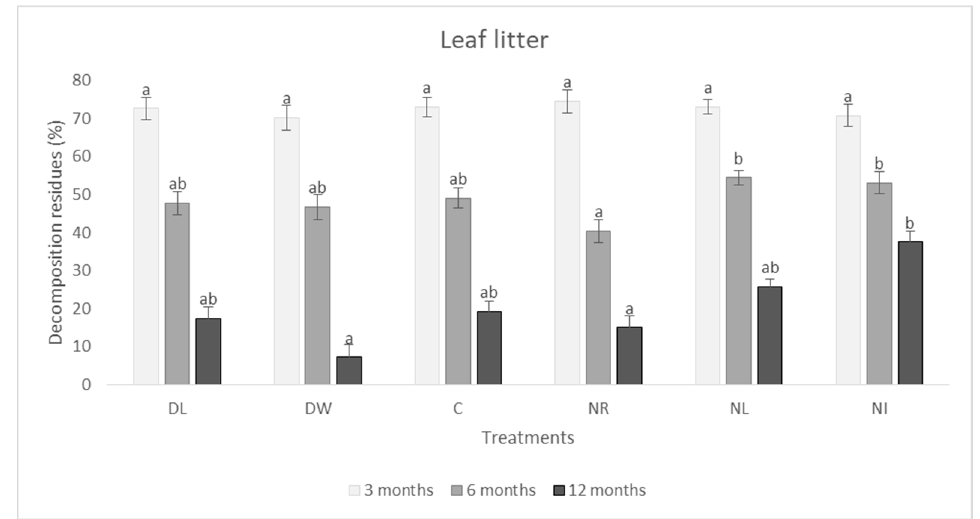
Figure 3. Effect of organic matter manipulation experiments with different DIRT treatments on leaf litter degradation rate after 3, 6 and 12 months: The letters represent significant differences between treatments during the given period ( n = 4).